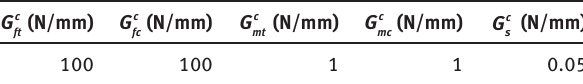
Table 6: Fracture energies for fiber-reinforced polymer composites (FRP) in